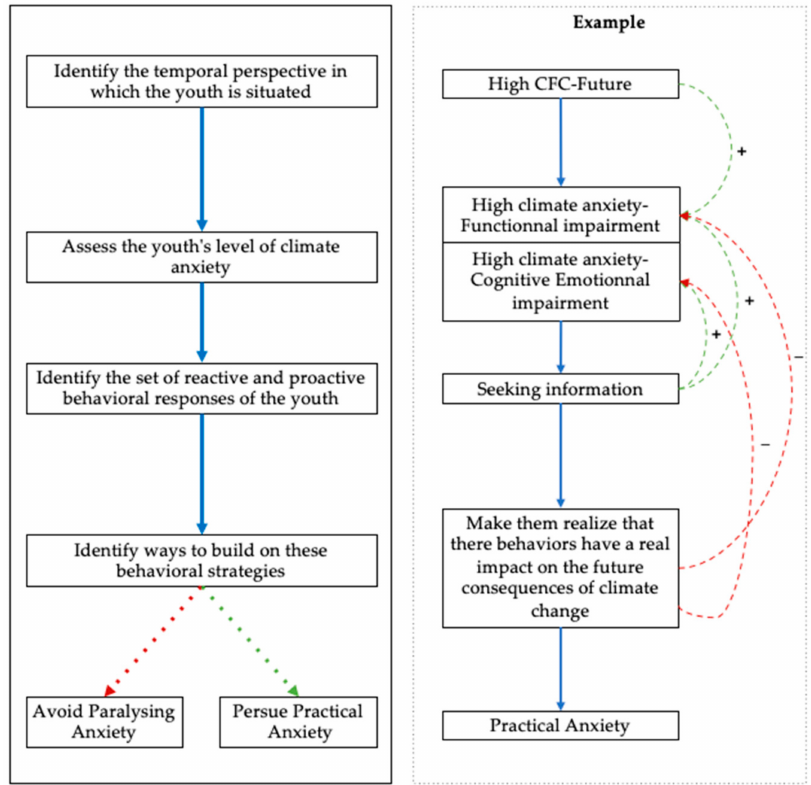
Figure 4. Accompanying a young person facing the emotional consequences of climate